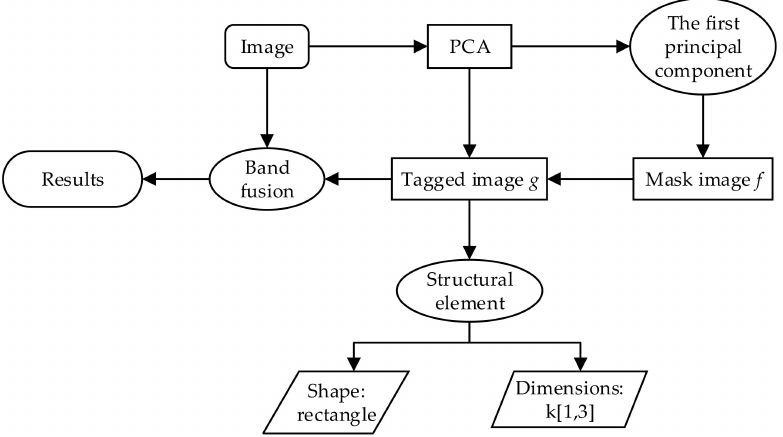
Figure 8. Flowchart of morphological image processing. PCA: Principal Component Analysis.